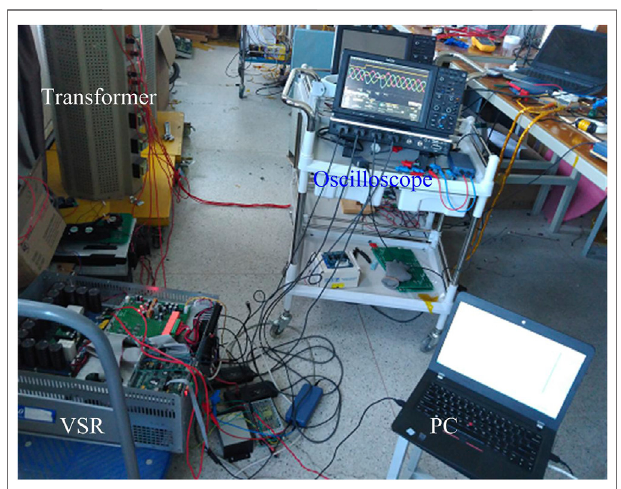
FIGURE 4 | Experimental platform.